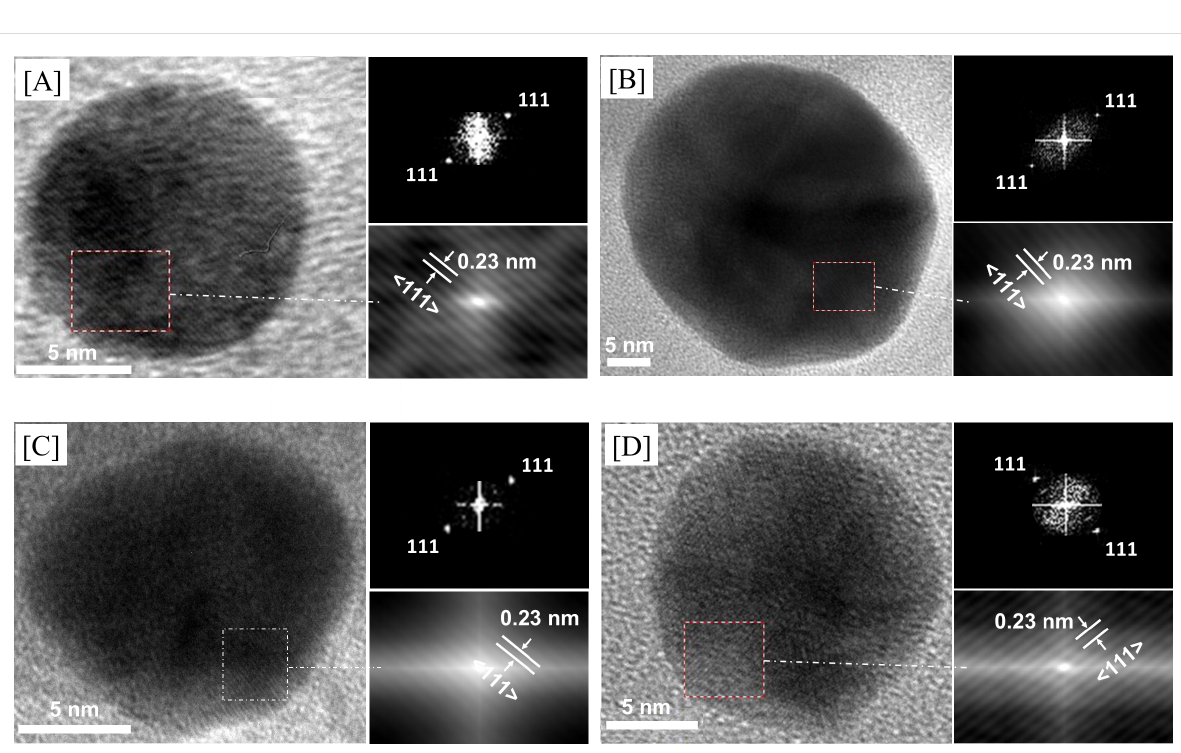
Figure 7: a) TEM images of [AuNPs] cal /silica hex films at 250 and b) 450 °C as well as c) [AuNPs] red /silica hex films at 210 and d) 250 °C. The insets show the corresponding FFT patterns (top) and auto-correlation images (bottom).